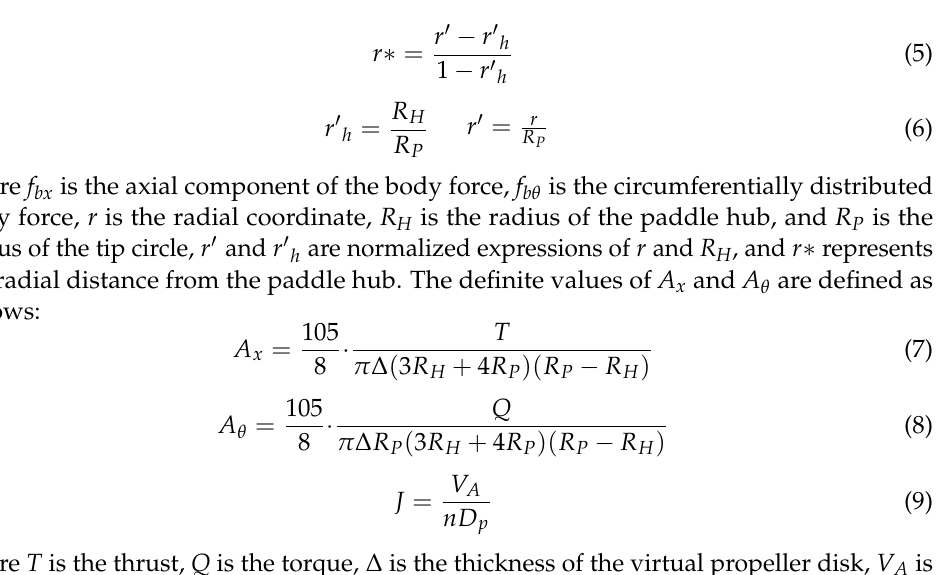
Figure 5. Open-water curve of propeller. Table 1. Hull elements ( λ = 1:42.8). Name